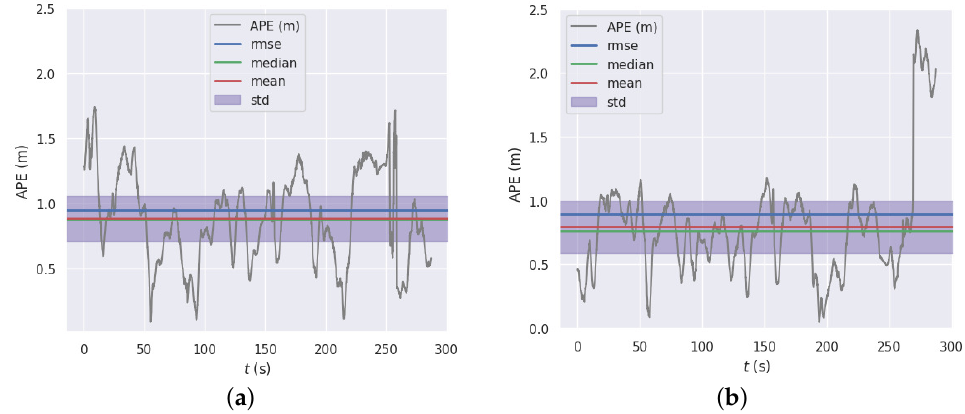
Figure 3. KITTI 05 dataset APE with regard to translation part(m) (with Sim(3) Umeyama alignment, while processing panning rotation and scale): ( a ) geometric method; ( b ) proposed